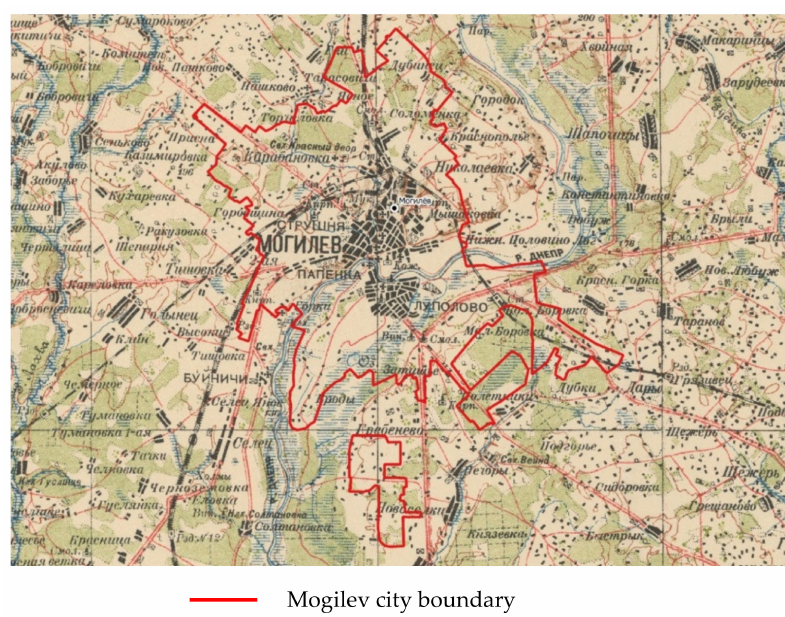
Figure A3. The Mogilev district map tile